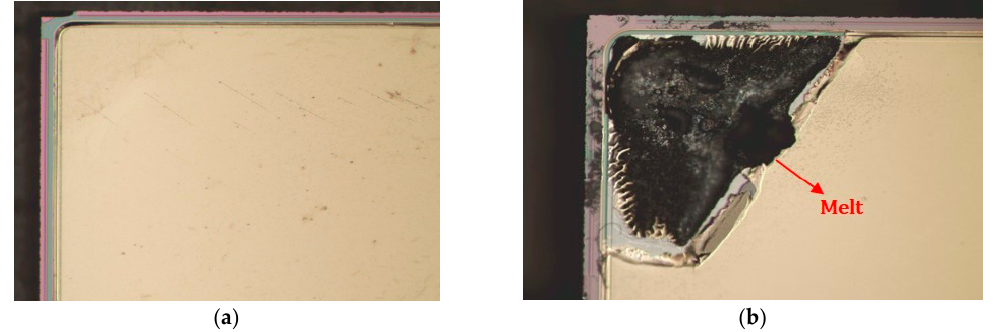
Figure 8. Cross-sectional images of ( a ) normal and ( b ) failed bypass diodes observed using optical microscope (×25). Energies 2018 , 11 , x FOR PEER REVIEW